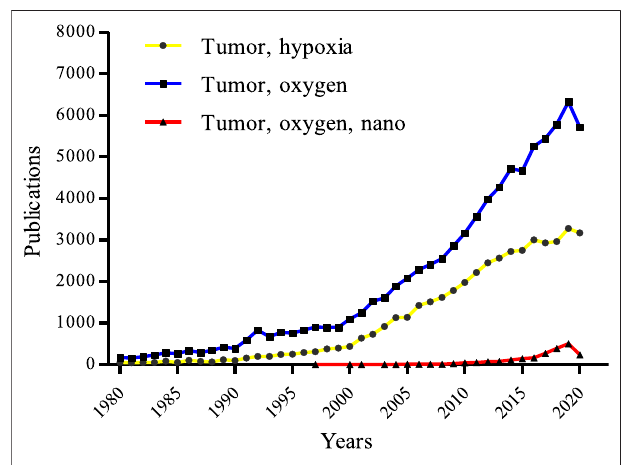
FIGURE 3 | Tumor hypoxia-related publications over the 4 decades from the core collection of Web of Science. The blue line, yellow line, and red line represent data using the keywords of “ tumor ” and “ oxygen ” , “ tumor ” and “ hypoxia ” , and “ tumor ” and “ oxygen ” , and “ nano ” , respectively (update to Dec 31,